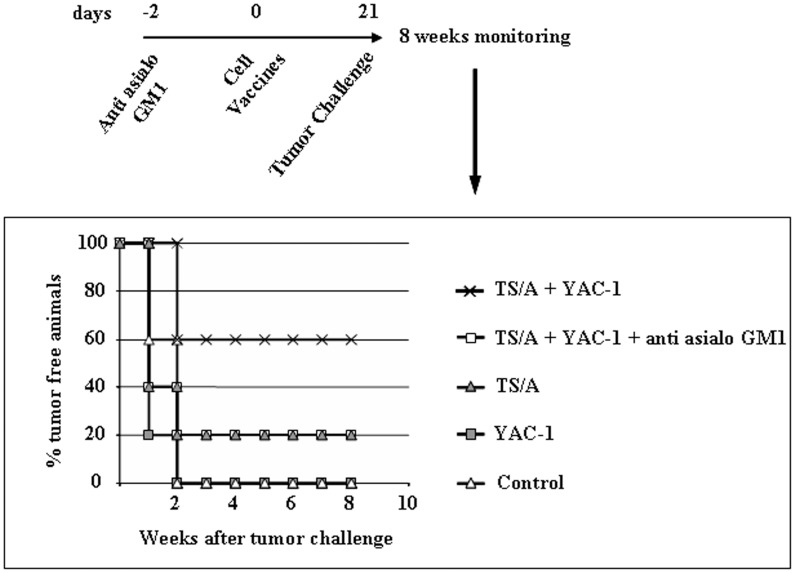
DC editing by NK cells generates a more protective immune response during cancer cell vaccination.Mice were vaccinated with immunogenic tumor cells alone (TS/A), tumor cells mixed with MHC-negative ells (TS/A + YAC-1) or MHC-negative cells alone (YAC-1) (five mice per group). In a group of mice, anti-asialo GM1 mAbs were administered i.p. 48 h before administration of cell vaccines to deplete NK cells. After 21 days, mice were challenged with a lethal dose of tumor cells and monitored for tumor growth twice a week for two months. Mice vaccinated with tumor cells mixed with MHC-negative cells (TS/A + YAC-1) displayed a delay in tumor growth and a striking survival to TS/A cancer cell challenge. This protective effect was abrogated when mice were depleted of NK cells (TS/A + YAC-1 + anti-asialo GM1).